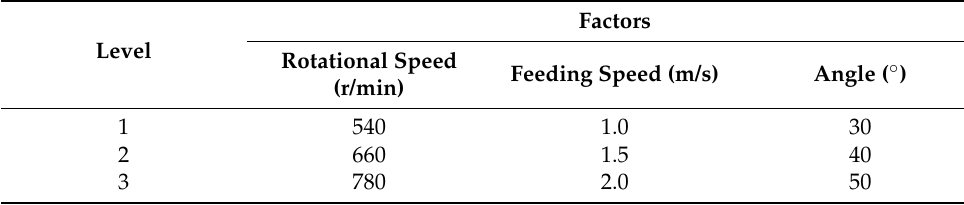
Table 2. Experimental factors and levels.